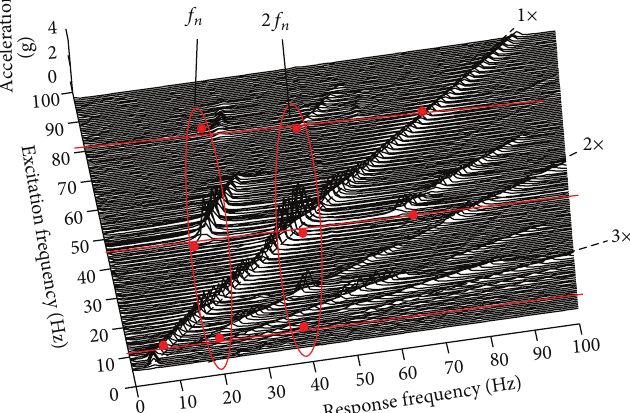
Figure 26: Cascade plot of the second disk